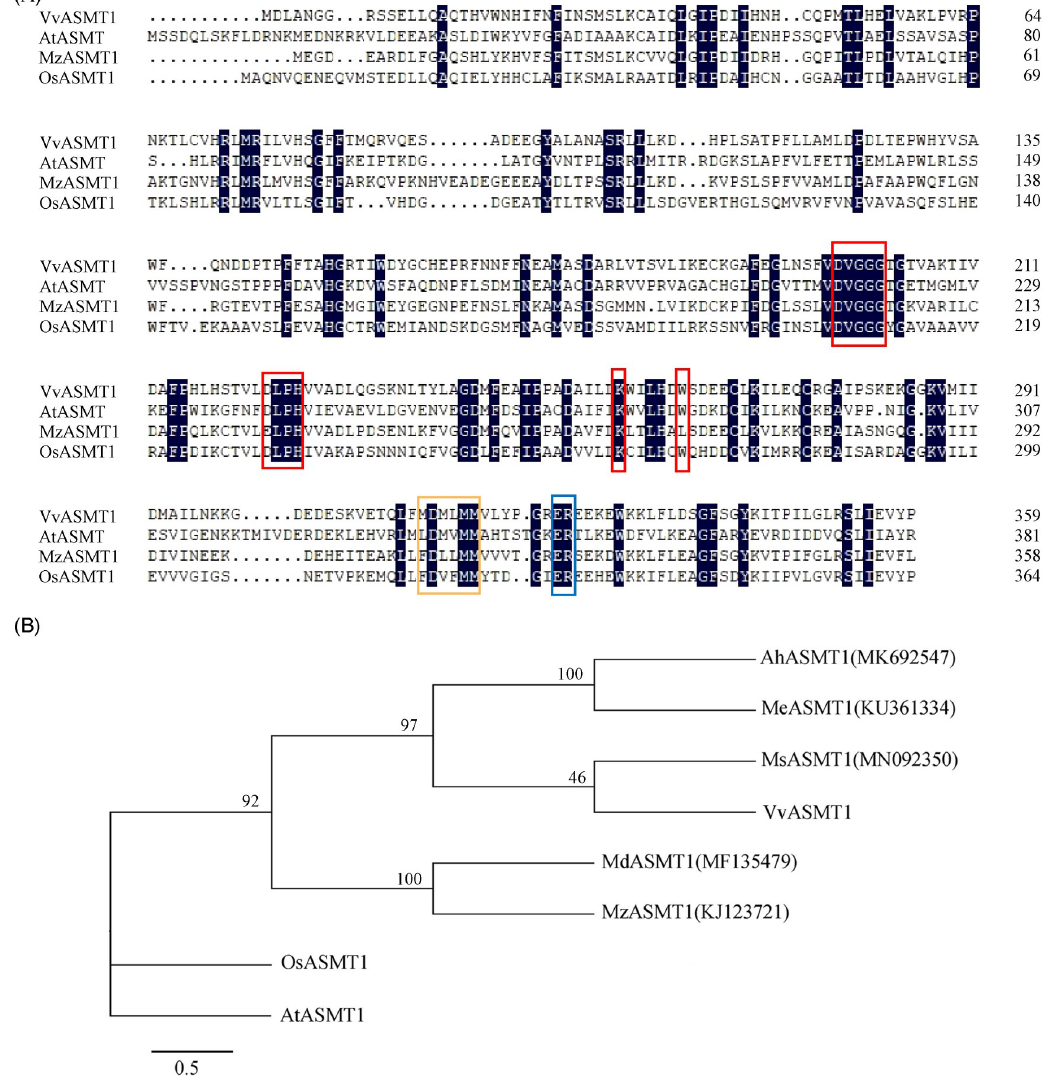
Fig 2. Sequence alignment and phylogenetic tree analysis of ASMT in different plants. (A) Amino acid sequence of VvASMT1 (XP_002278316) in grapevine was compared with AtASMT1 in Arabidopsis , OsASMT1 in rice and MzASMT1 in apple. The same amino acids are covered in black, the binding region of adenosine -L- methionine is marked by red frame, the binding region of substrate is marked by blue frame, and the catalytic region is marked by orange frame. (B) Phylogenetic relationship between VvASMT1 and ASMT1s in other plants. Each gene is followed by its ID, and the abbreviation of the species name is before the genetic name. Ah, Arachis hypogaea ; At, Arabidopsis thaliana ; Os, oryza sativa ; Me, Manihot esculenta ; Ms, Medicago sativa ; Mz, Malus zumi ; Vv, Vitis vinifera